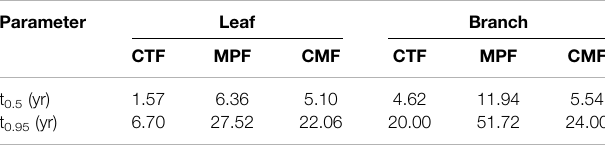
TABLE 6 | Time required for 50 and 95% of litter mass loss in the three examined subtropical forest